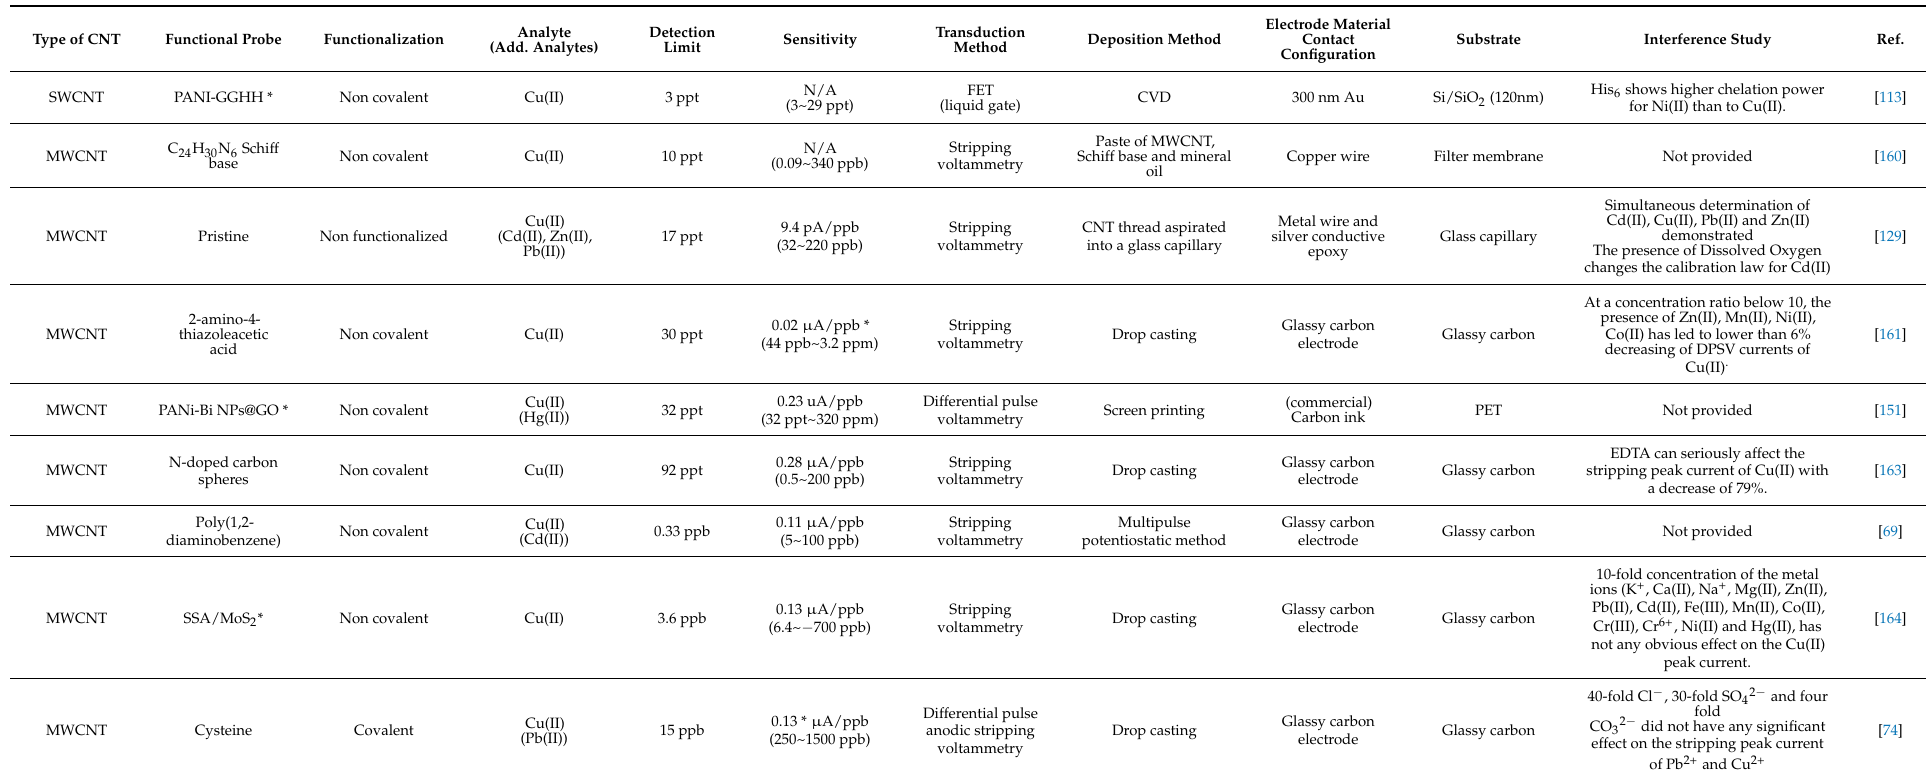
Table 8. CNT-based sensors for detecting Cu(II) ions in water, sorted by detection